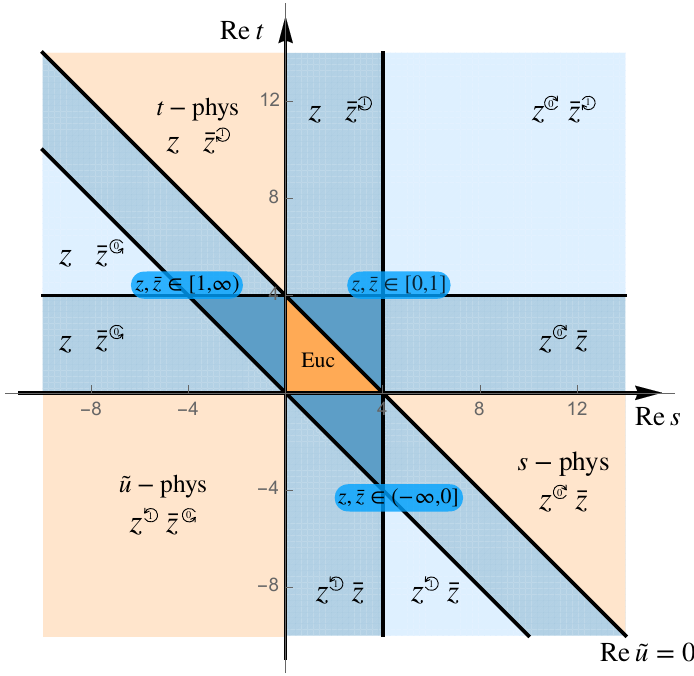
Figure 19. Analytic continuation of cross ratios on the real s − t plane. The orange triangle is the Euclidean region and where all analytic continuations start from. The larger triangle (including the Euclidean region) is the region where u and v stay in their principal branch. It is also the so-called Mandelstam triangle where all Mandelstam variables are below their two-particle threshold. The lighter orange regions correspond to s/t/ ˜ u -physical region, respectively. All the blue regions are Lorentzian regions where z and ¯ z are real and independent, and lie within the indicated intervals. The round arrows (notice the different directions) indicate how the cross ratios z, ¯ z should be analytically continued through the ( −∞ , 0] or [1 , ∞ ) branch cut in the complex plane. In unlabelled regions z, ¯ z stay in the principal